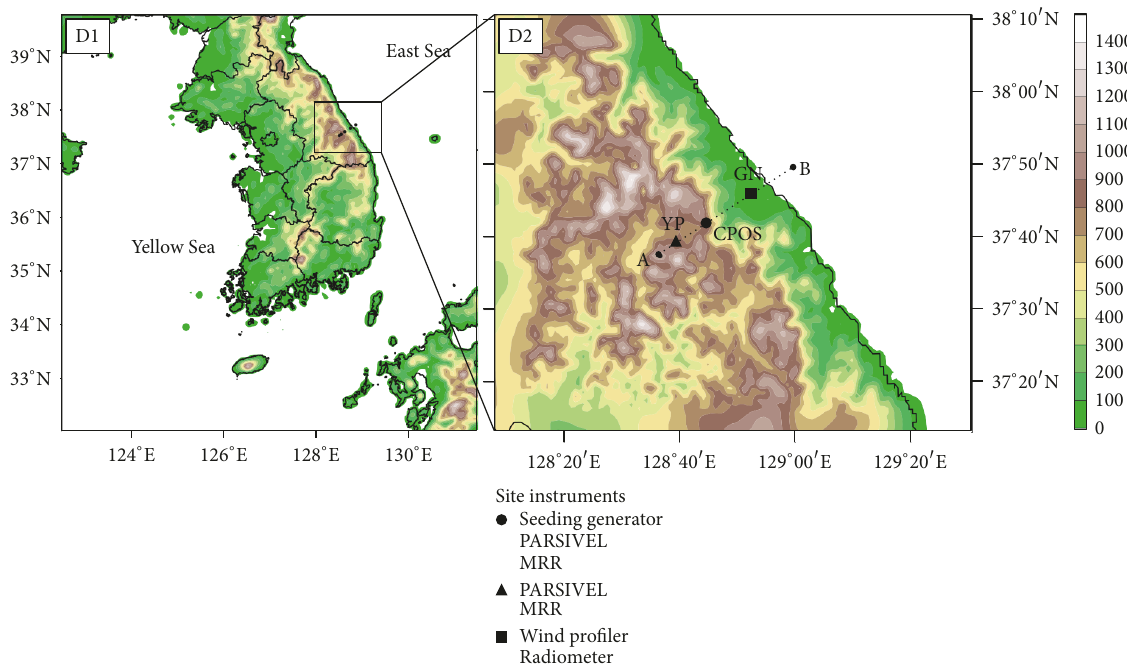
Figure 1: The model domain and topography of the experimental region. The triangle, circle, and square indicate the locations of the Yongpyeong observatory (YP), Cloud Physics Observation Site (CPOS), and Gangwon Regional Office of Meteorology (GN), respectively. The dashed line from A to B represents the horizontal cross section passing through YP, CPOS, and